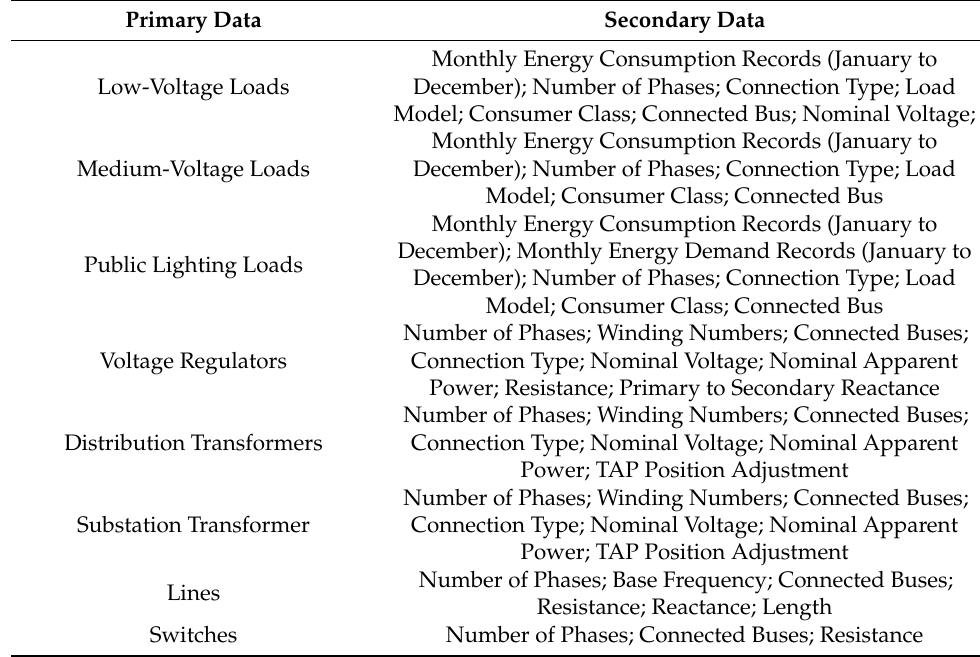
Table 2. Electrical parameters of rural feeders. Source: The